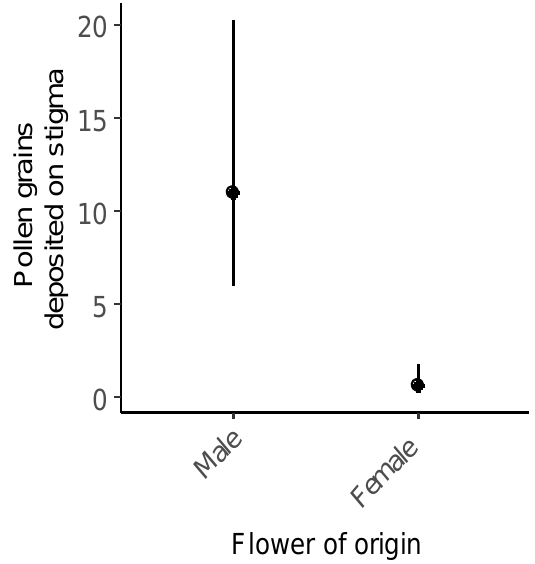
Figure 6. The influence of flower of origin, male ( N = 48) and female ( N = 55), on the number of pollen grains deposited on the stigma of a female flower ( P < 0.0001). Points represent model-adjusted means and lines represent the 95% CI.